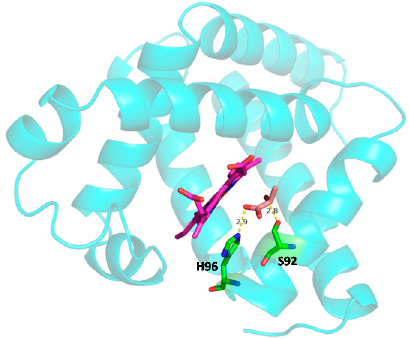
Figure 3. Autodock results displaying LAC interaction with deoxy-Mb residues. Irrespective of the